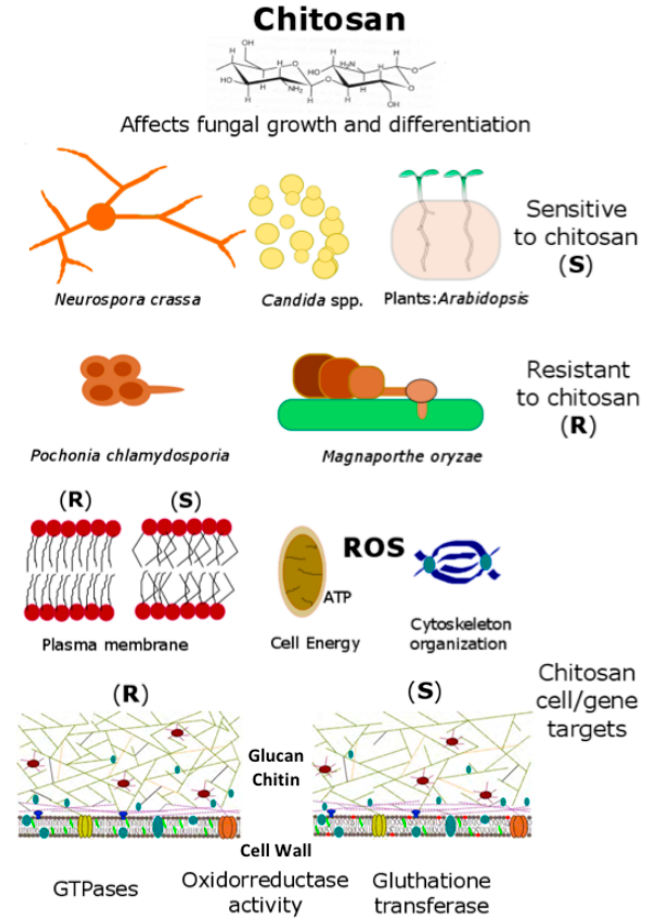
Figure 2. Conceptual diagram of chitosan as antifungal and gene modulator in fungi and plants (modified from